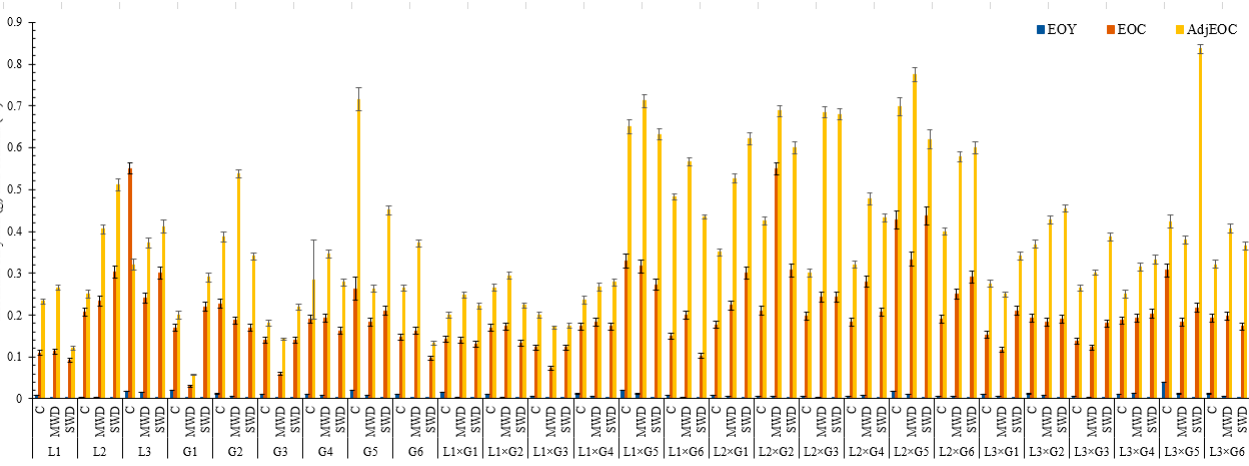
Figure 7. Water treatment (WT) × genotype interaction effect on essential oil content (EOC), essential oil yield (EOY), and L 1 –L 3 : 3 testers, G 1 –G 6 : 6 male parents; L 1 G 1 –L 2 G 6 : 12 single hybrids, and L 3 G 1 -L 3 G 6 : 6 three-way hybrids in a modified triple test cross. Adjusted essential oil content (AdjEOC). C: control; MWD: moderate water deficit; SWD: severe water deficit.